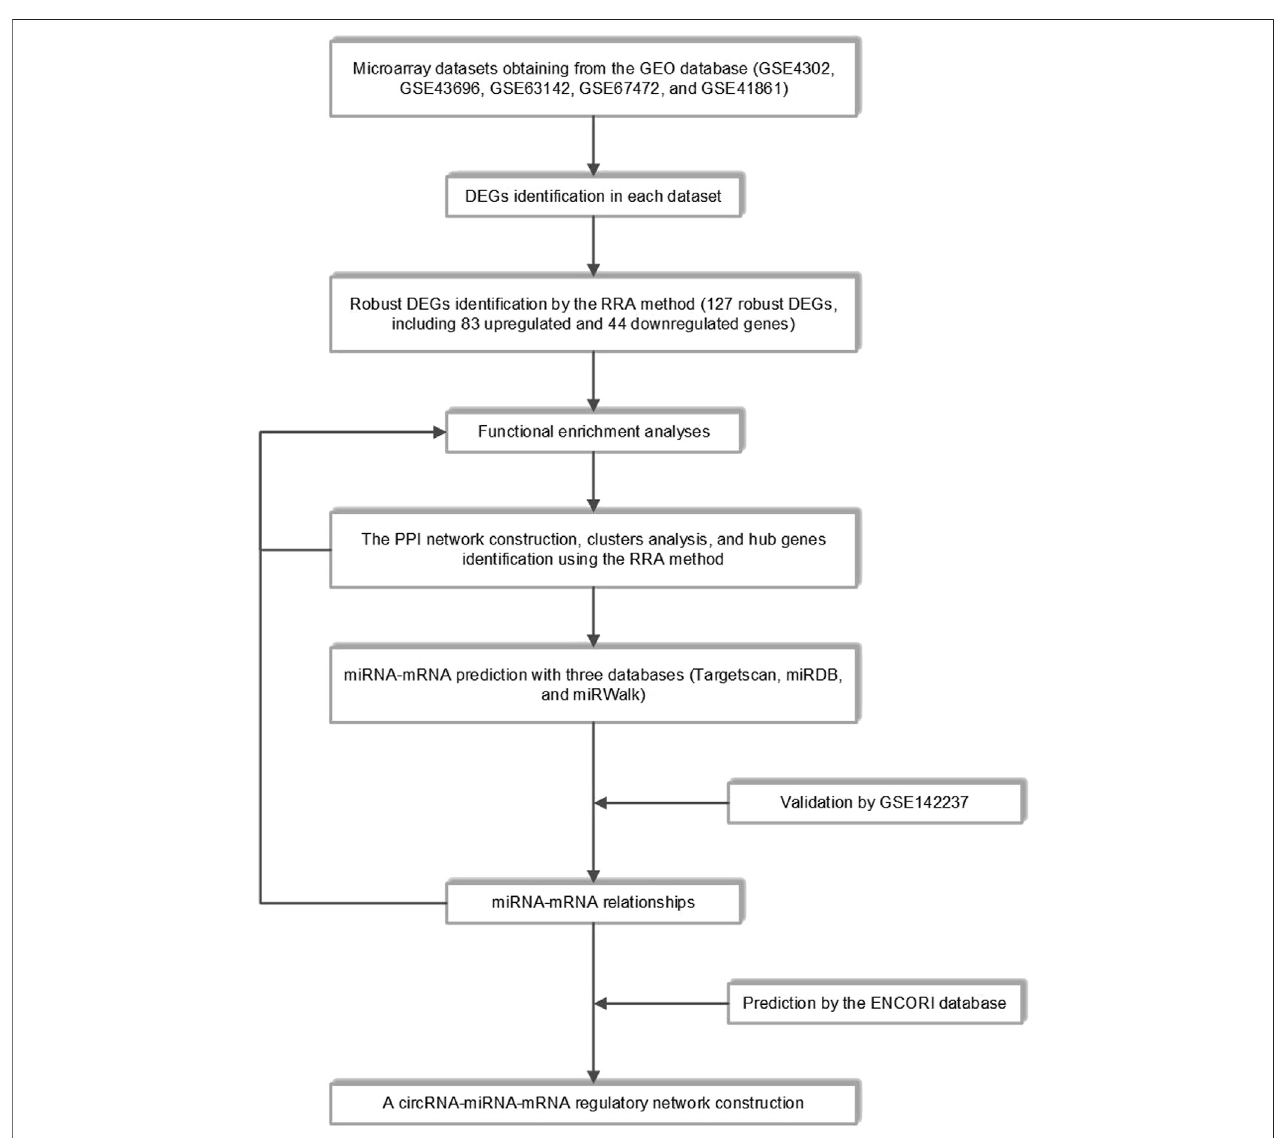
FIGURE1| Thewholestudywork fl ow.GEO,GeneExpressionOmnibus;DEGs,differentiallyexpressedgenes;RRA,robustrankaggregation;PPI,protein-protein interaction.